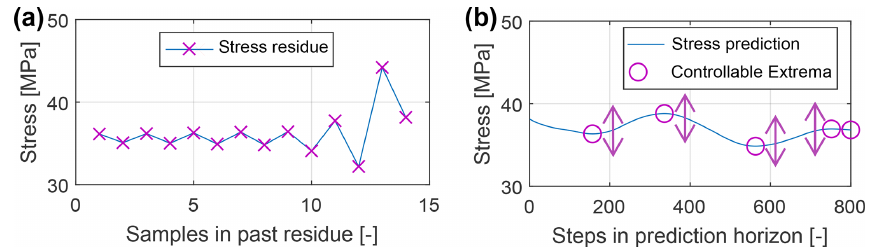
Figure 3. Stress residue from the past (a) . Stress prediction into the future (b) .